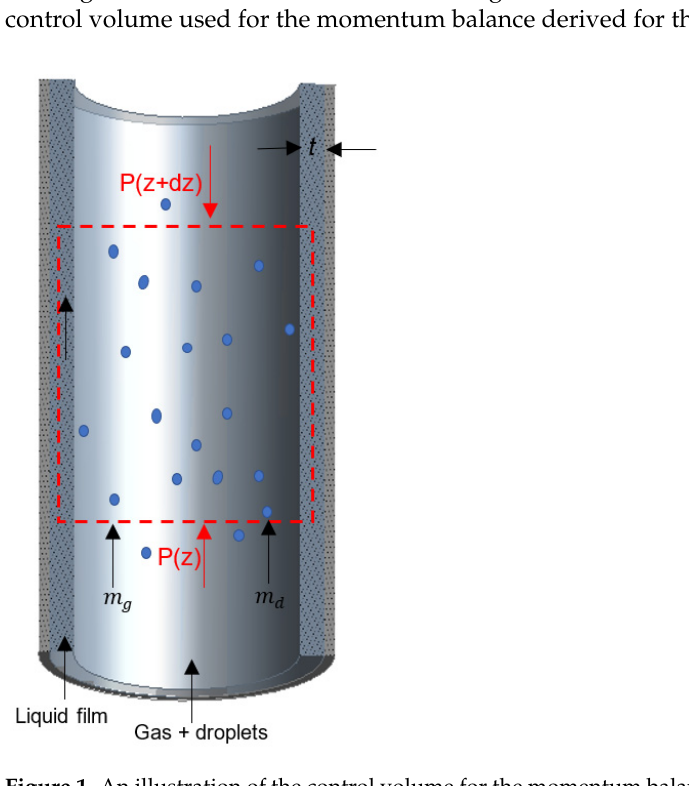
Figure 1. An illustration of the control volume for the momentum balance in Equation (14). (Adapted from Wongwises and Kongkiatwanitch, [24]; and Aliyu et al., [25]). The momentum (force) balances for the liquid film and core are given by Equations (1) and (2) respectively as follows: